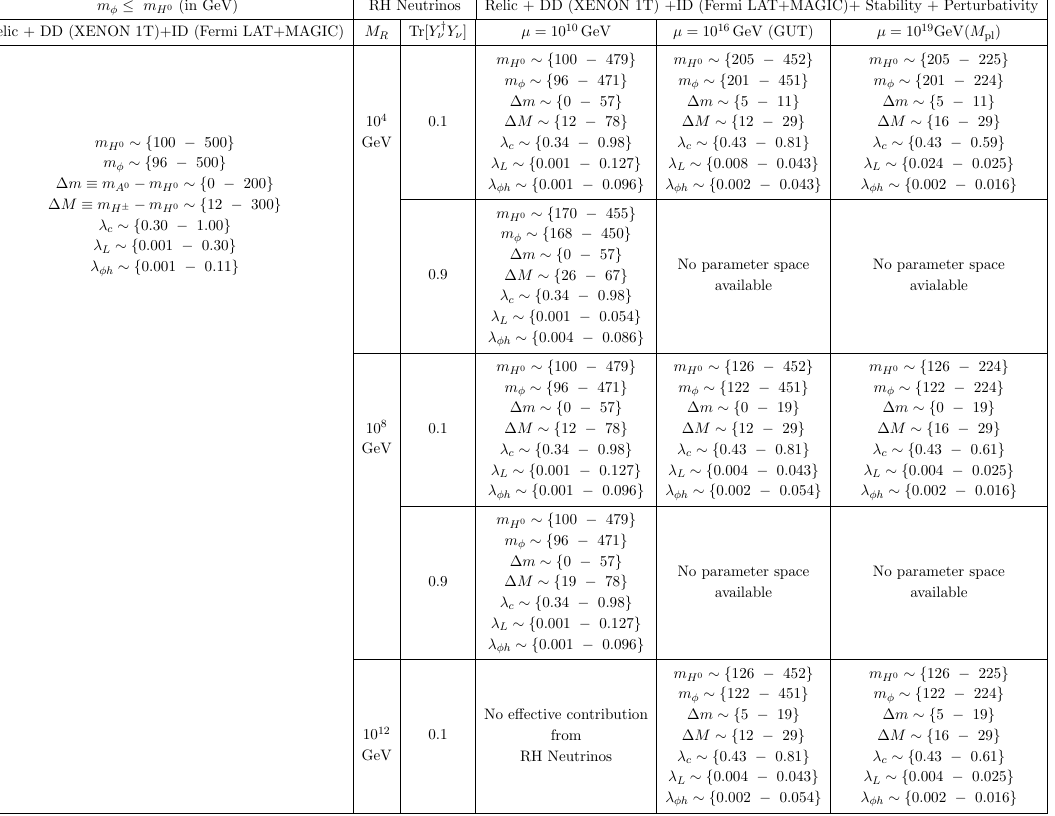
for di(cid:11)erent values of RH H 0